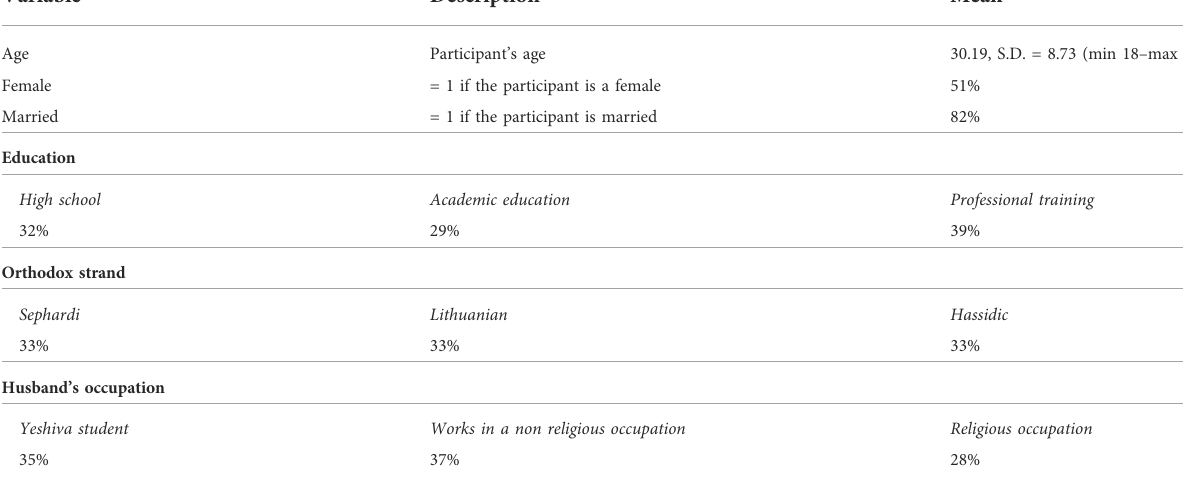
TABLE 2 Sample ’ s descriptive statistics.